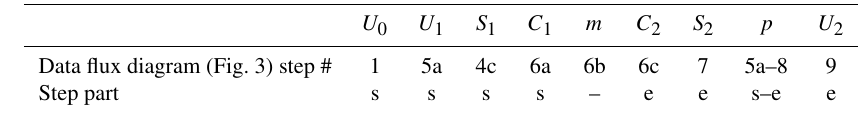
Figure 3. Data flux diagram. The downward-oriented vertical coordinate is the time elapsed since the user started interacting with VISIR, while the horizontal coordinate goes from high-level to low-level operations. Orange shading indicates simultaneously occurring operations. The dotted lines indicate replicas of steps (5a) and (5a (cid:48) ), performed until CDAM results are made available to the MB. The correlation-ID identifies the VISIR job, see route register in Fig. 7a and Sect. 7. Table 2. Correspondence between steps within the data flux diagram (Fig. 3) and nodes of the VISIR system (cf. Fig. 4). The step part (s: start, e: end) is also given when relevant (– otherwise).